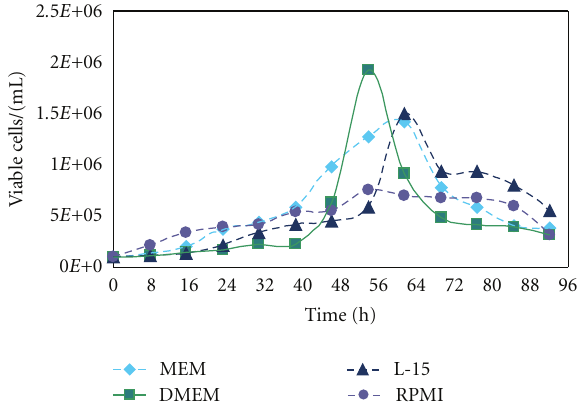
Figure 3: Cell attachment of Vero cells on four di ff erent microcarri- ers viewed under inverted light microscope at magnification of 20x: (a) Cytodex 1; (b) Cytodex 3; (c) Hillex; (d) Plastic Plus